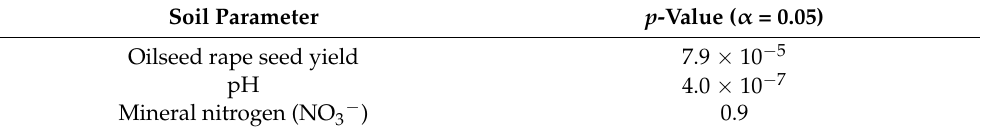
Table 4. ANOVA for the effect of biochar on the seed yield of oilseed rape, soil pH, and soil mine- ral nitrogen. Soil Parameter p -Value ( α =